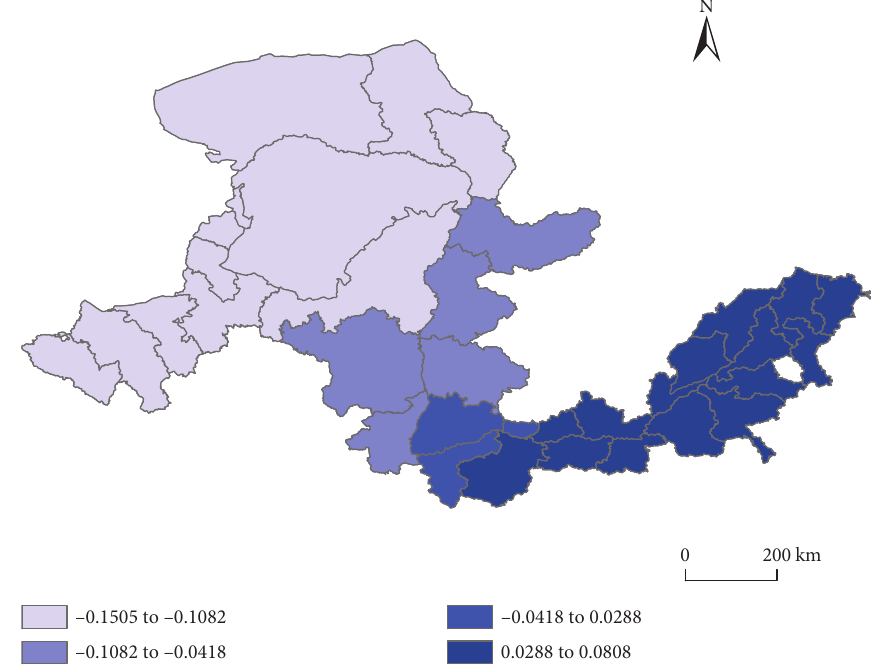
Figure 6: Spatial distribution of the regression coefficient of the reduction rate of energy consumption on IGD.